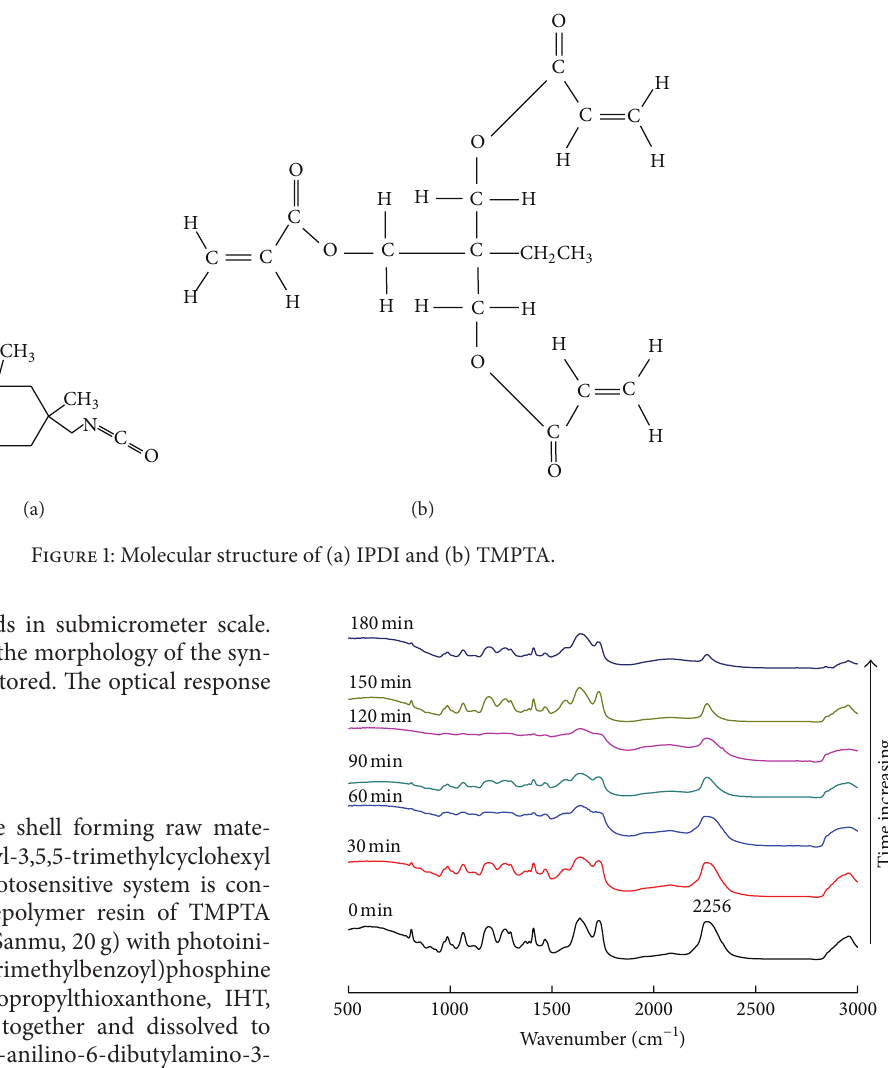
Figure 2: FT-IR spectra variance of the emulsions when emulsifica- tion time